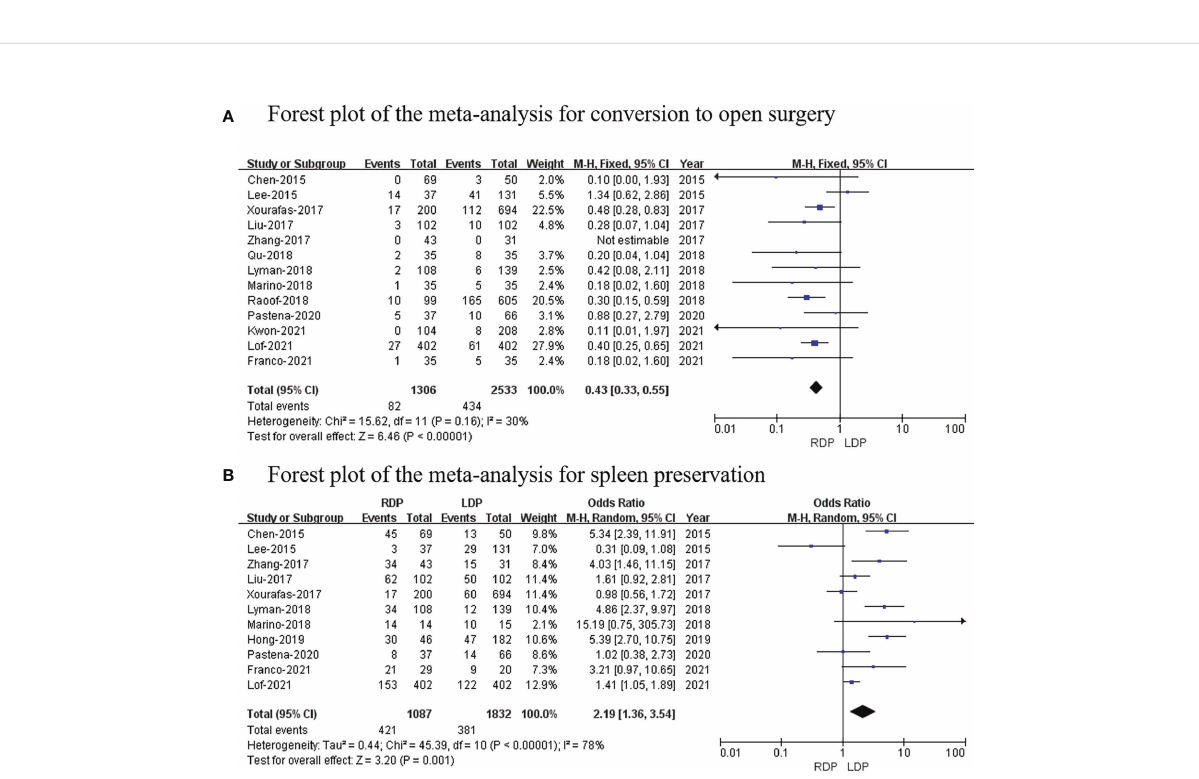
FIGURE 6 Forest plot of the meta-analysis for (A) conversion to open surgery and (B) spleen preservation.